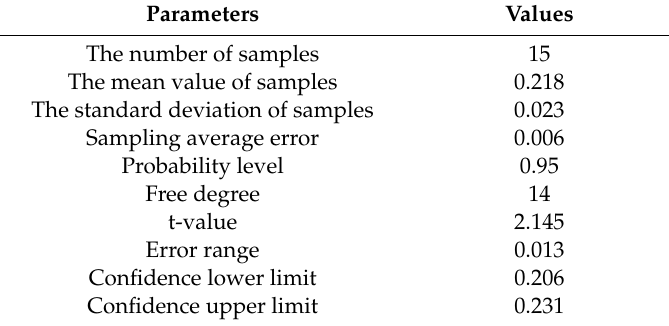
Table 15. The confidence limit calculation of mixture porosity of 15 real aggregate shape